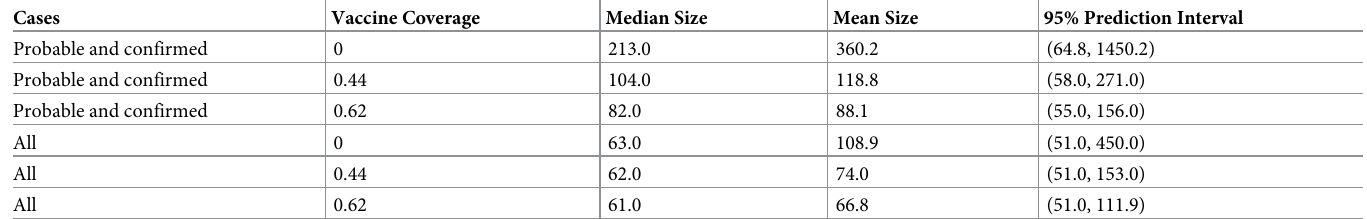
Table 1. Distribution of projected outbreak size from stochastic branching process model. Mean, median and 95% prediction interval of outbreak size, by proportion of vaccine coverage, using probable and confirmed cases with and without suspected cases.